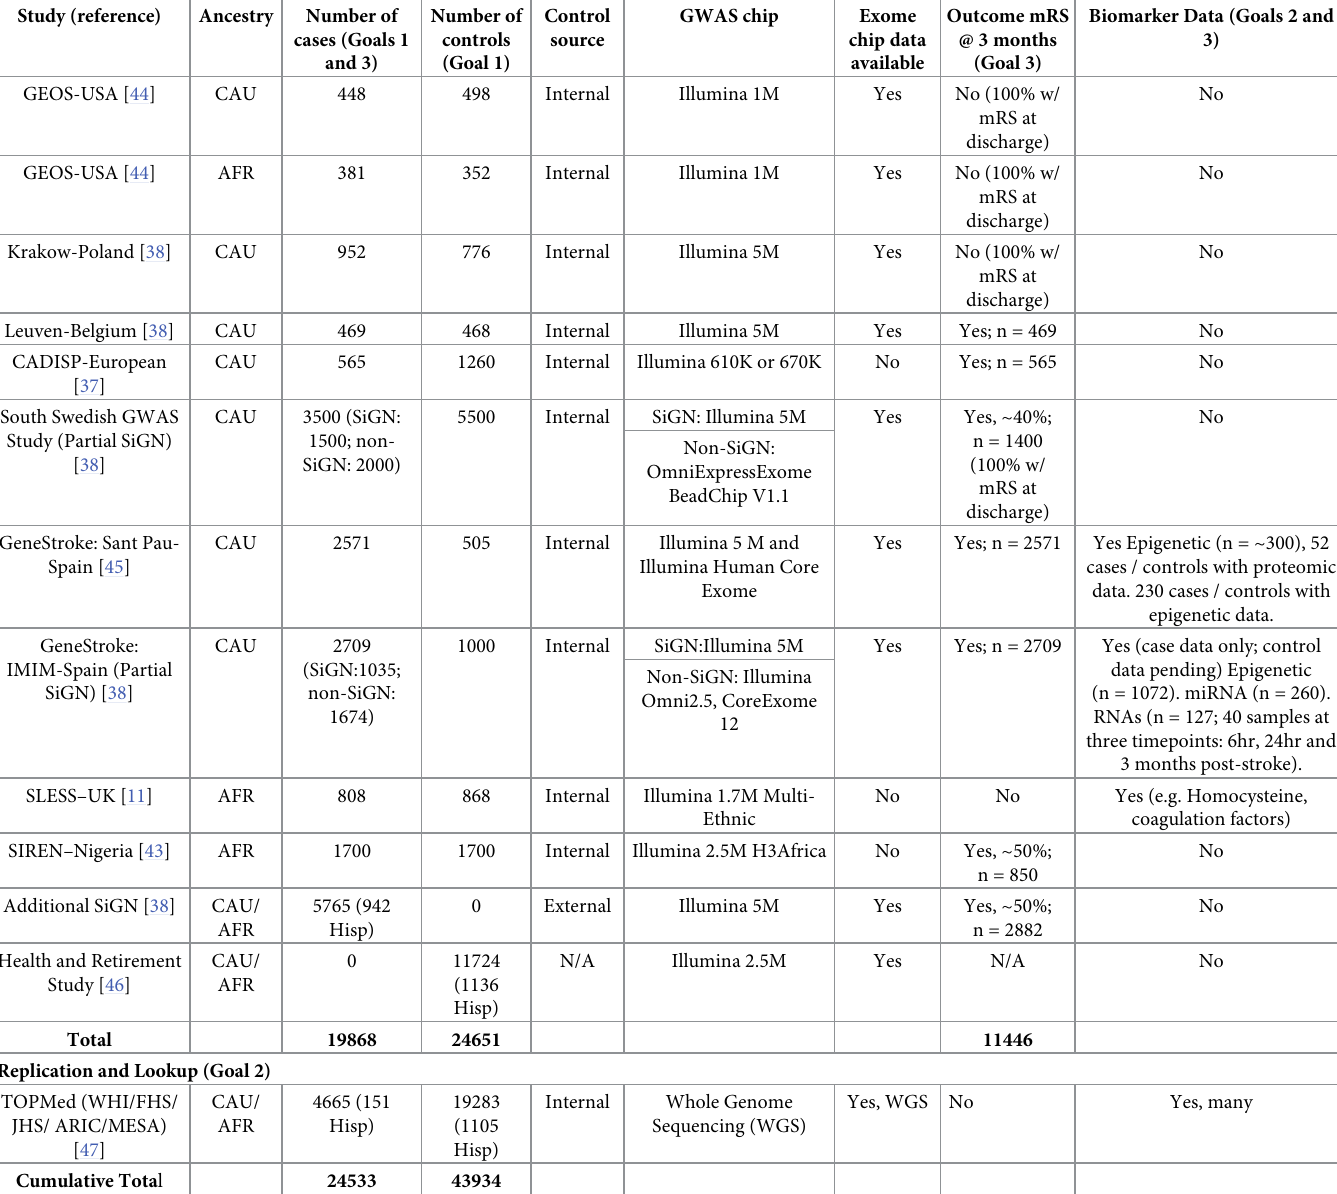
Table 2. Summary of CaNVAS study subjects and other cohort specific